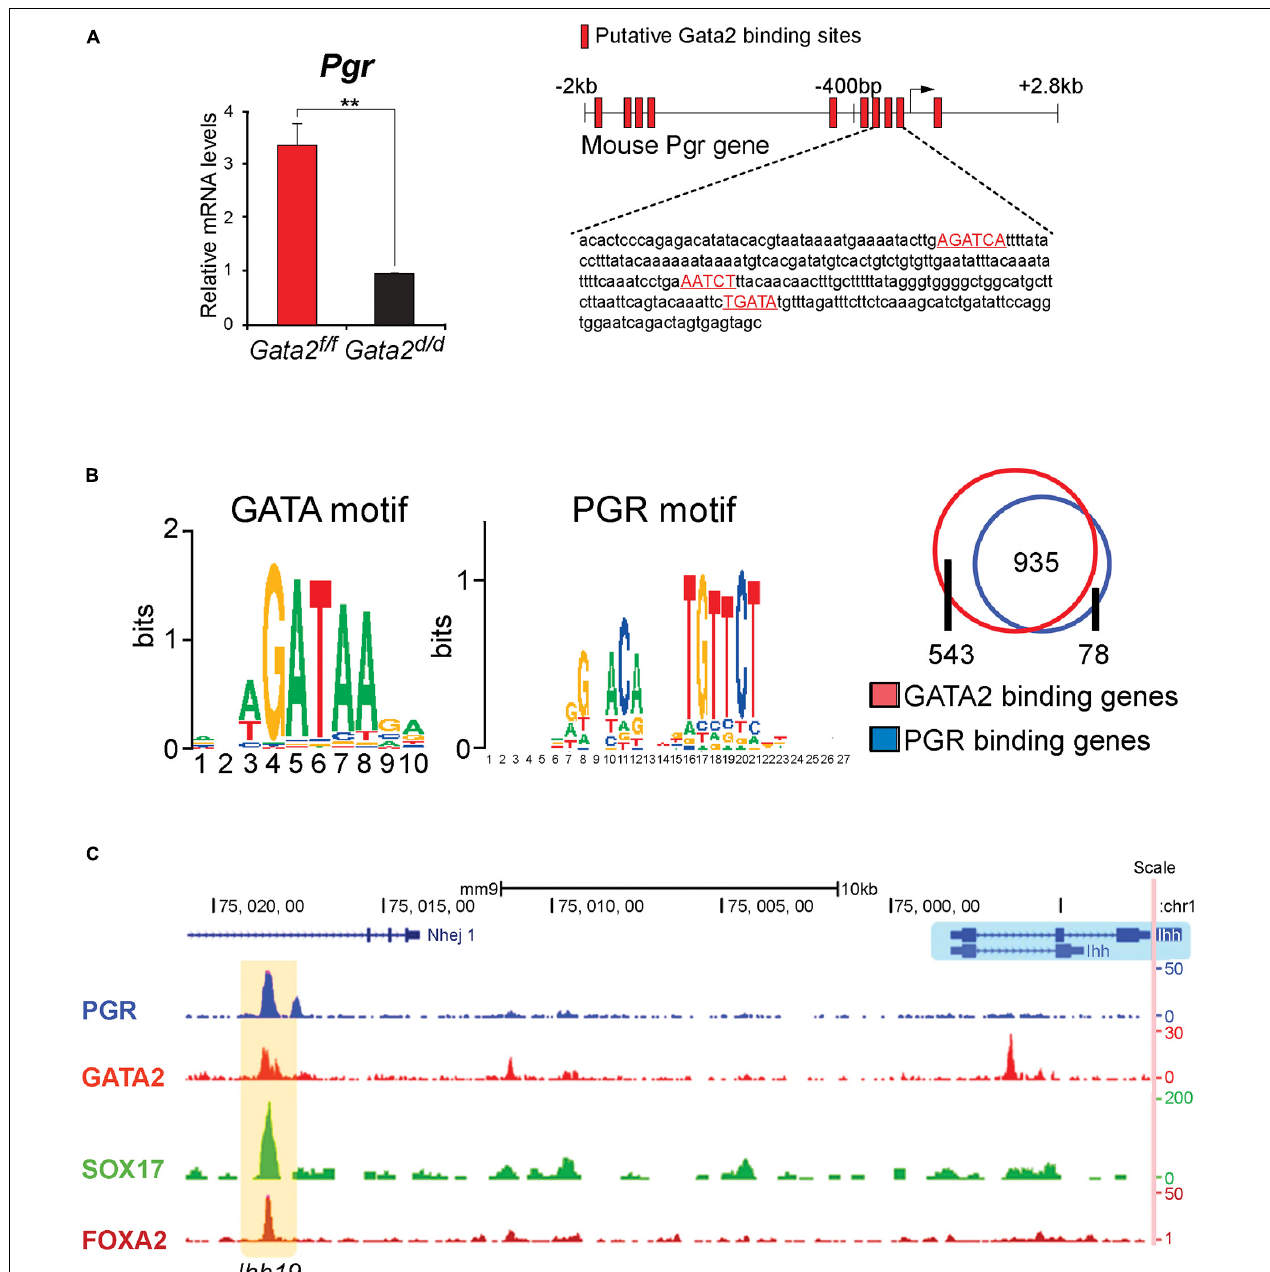
FIGURE 3 | The GATA2 transcription factor is a direct epithelial modifier of PGR-mediated transcription in the murine endometrium. (A) Quantitative real-time PCR analysis reveals that absence of GATA2 in the endometrium of the ovariectomized mouse results in a significant reduction in Pgr transcript levels. Note: in the uterus of an ovariectomized control mouse, the majority of Pgr expression in located in the epithelial compartment (Rubel et al., 2016). Also note that the GATA2 transcription factor is conditionally ablated in PGR positive cells of the uterus in the Gata2 d / d mouse. In silico analysis highlights numerous candidate DNA binding motifs for GATA2, which are located throughout the 5 (cid:48) regulatory regions of the murine Pgr gene (red boxes) and red highlighted sequences. Chromatin immunoprecipitation and in vitro transient transfection experiments confirmed that many of these binding sites directly bind GATA2 and are functional (Rubel et al., 2016). (B) Using uterine tissue from ovariectomized mice treated with progesterone for 6 h, chromatin immunoprecipitation followed by genome-wide sequencing (ChIP-seq) identified enriched binding motifs for the GATA2 and PGR transcription factors within GATA2 binding intervals throughout the genome. The Venn diagram displays the progesterone responsive genes in the mouse uterus that contain binding sites for PGR or GATA2 within ± 25 kb of gene boundaries. Note: the significant overlap (935 genes) that represent genes jointly bound by PGR and GATA2 (Rubel et al., 2016). (C) The traces show the co-occupancy locations of the PGR, GATA 2, SOX17, and FOXA2 transcription factors at a distal enhancer region on the murine Ihh gene (Wang et al., 2018). Note: SOX17 is also a direct target of GATA2 and PGR (Wang et al., 2018); the FOXA2 transcription factor (not covered in this review) is critical for uterine glandular epithelial function that is required for pregnancy establishment (Kelleher et al., 2017). With permission, parts of this schematic were reproduced in modified form from Rubel et al. (2016) and Wang et al. (2018). ** p < 0.01.